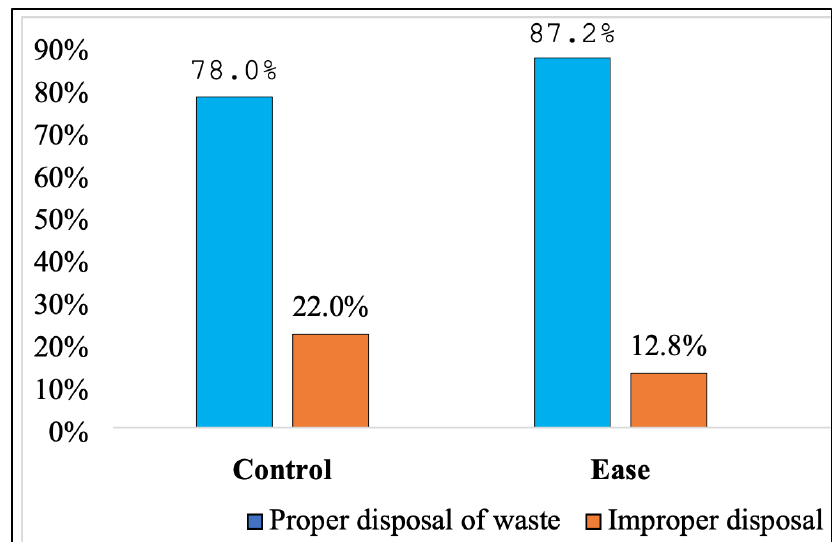
Figure 4. Proper or improper disposal of waste by treatment